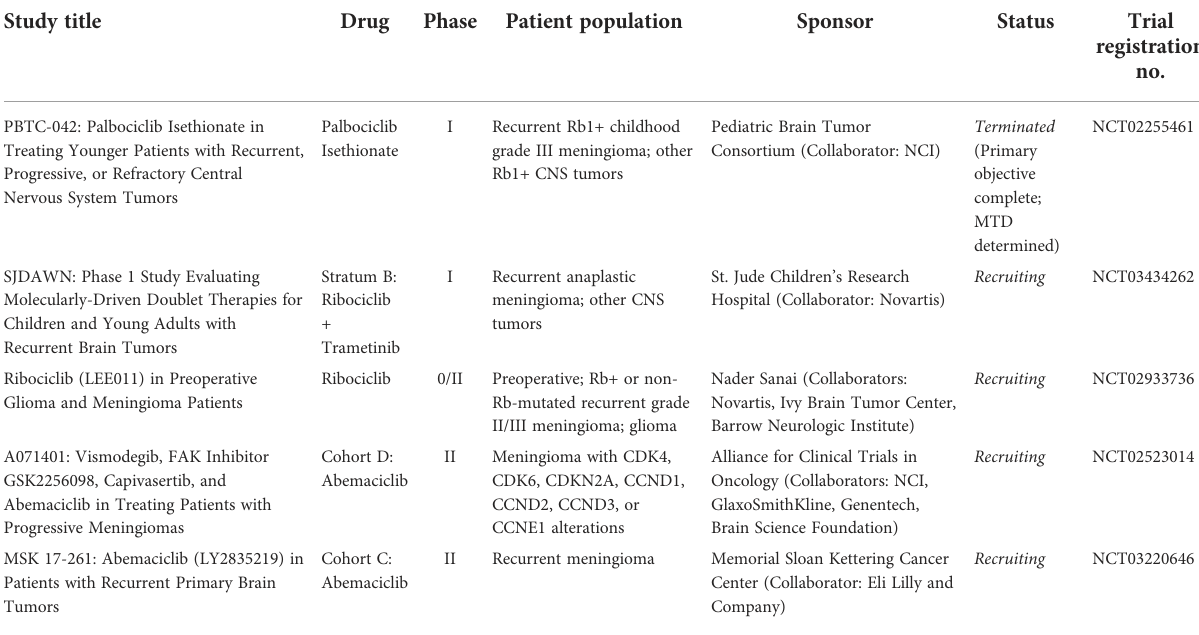
TABLE 1 Ongoing CDK inhibitor trials for